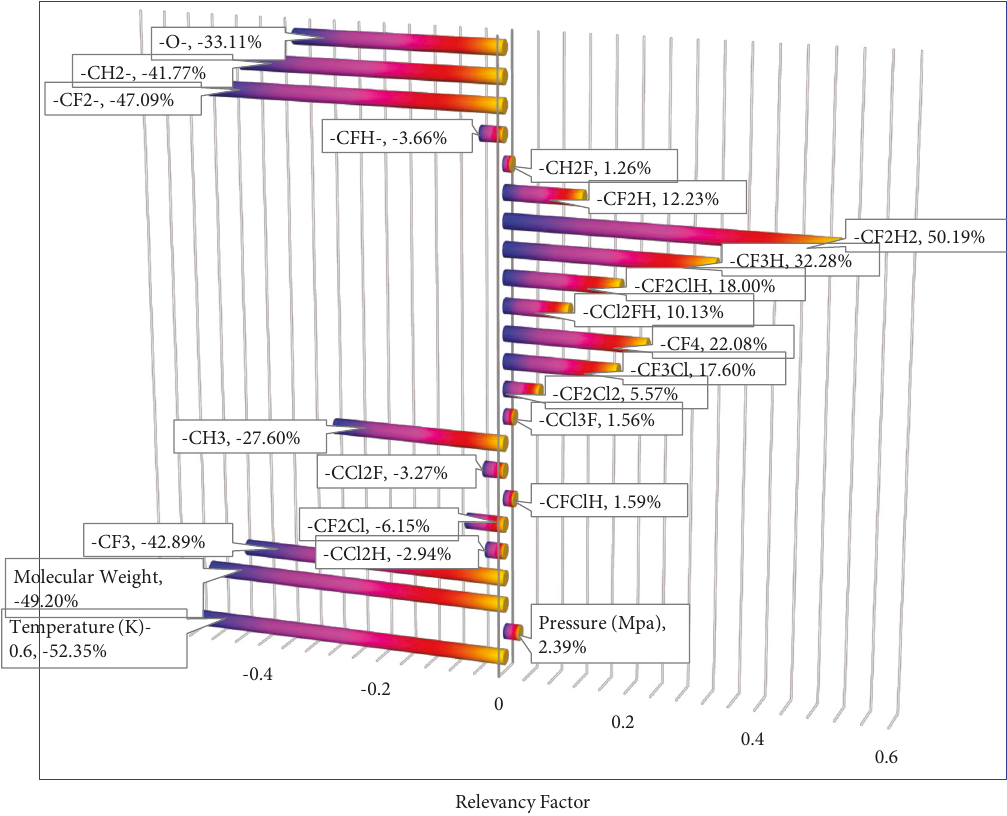
Figure 6: Sensitivity analysis to determine the effect of inputs on density